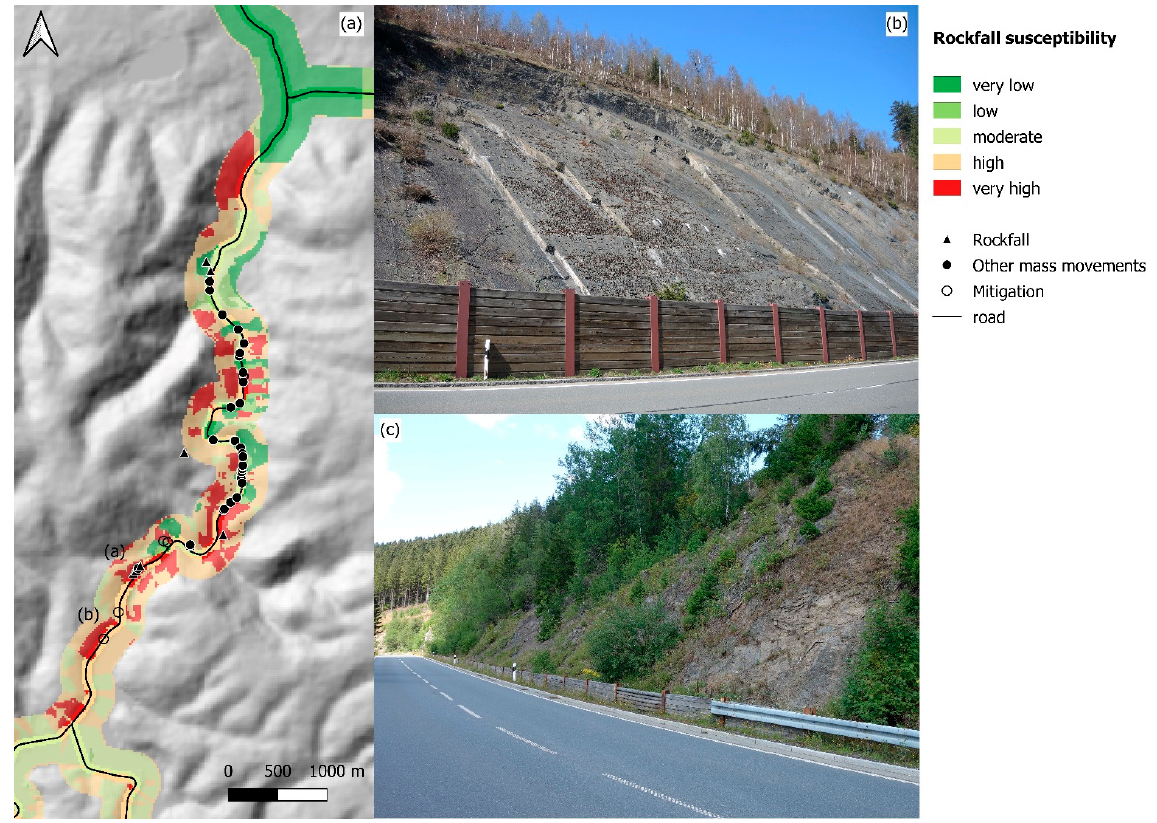
Figure 5. ( a ) Rockfall susceptibility of the Oker valley. For better visibility, the susceptibility is shown in a 500 m corridor. In addition to rockfall and mitigation, other mass movements are displayed. The position of the photos ( b , c ) is shown in ( a ).